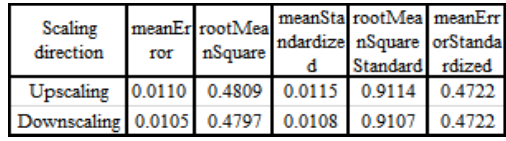
Table 1. Parameter statistical table of land parcel units and pixels cross validation